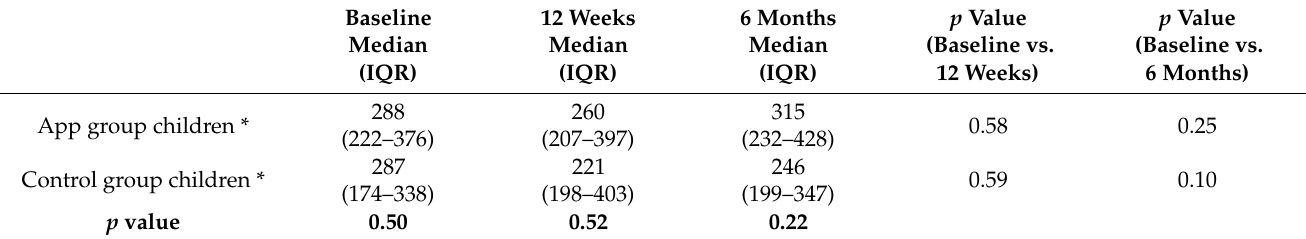
Table 8. Median blood Phe levels at baseline, 12 weeks, and 6